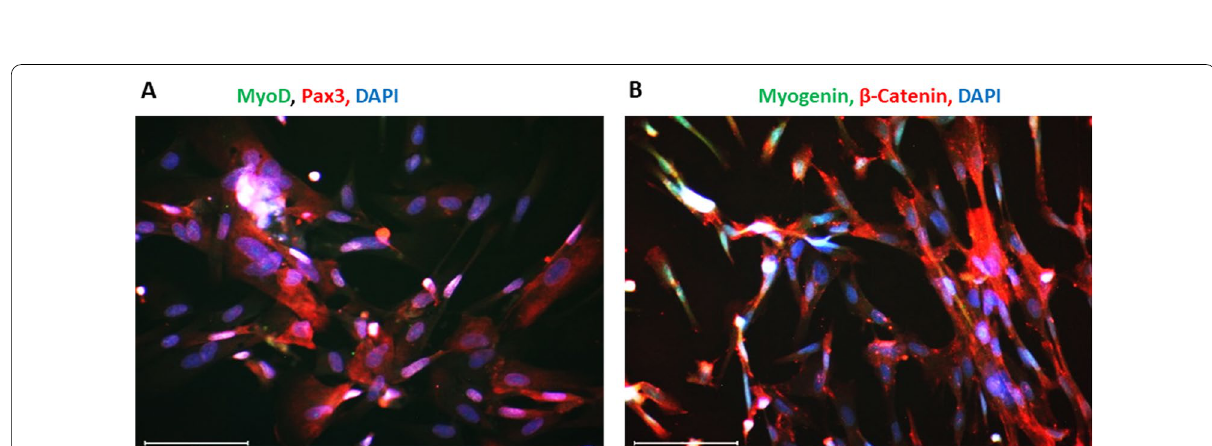
Fig. 6 Effect of GIV on differentiation of hiPSCs to skeletal myogenic cells: Effect of GIV on differentiation of hiPSCs to skeletal myogenic cells. Cells were positive for skeletal myoblast markers Pax3, MyoD, myogenin and β-catenin (40X) at 30 days after